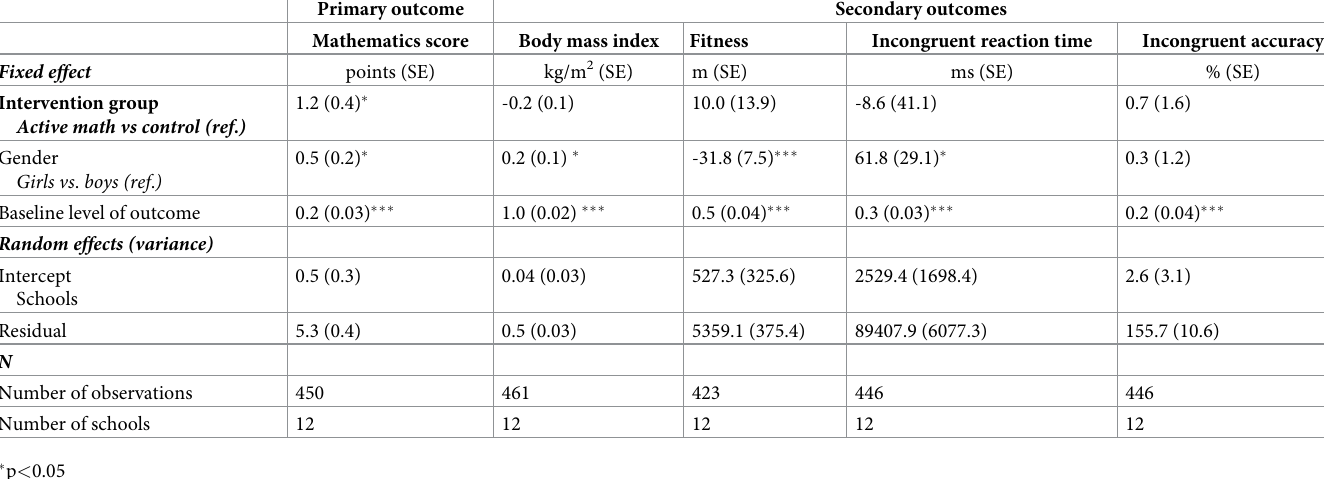
Table 4. Difference at follow-up between intervention and control in primary and secondary outcomes—adjusted for baseline level of the outcome, sex and school as random effect. Mixed effect model